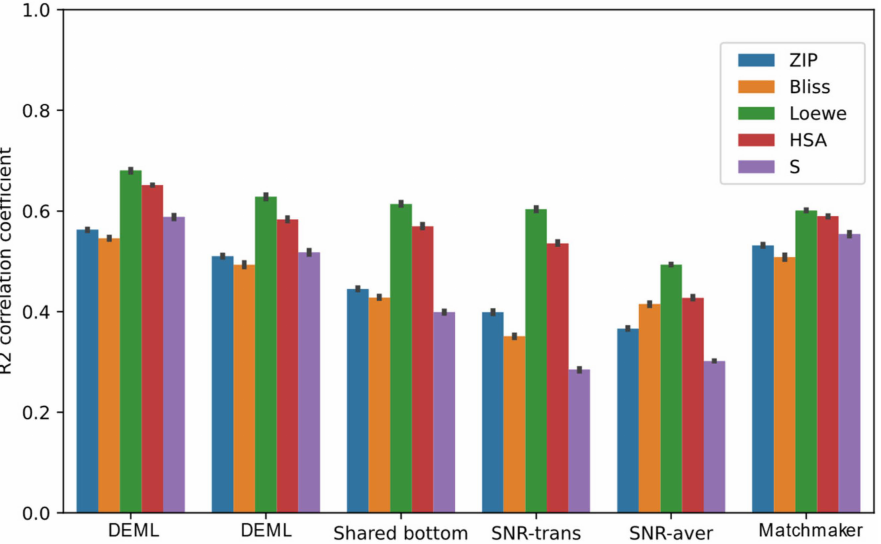
Figure 5. Prediction performance of DEML and multi-task comparison algorithms in all synergy regression prediction tasks. MatchMaker single-task refers to the best prediction performance with MatchMaker trained on each task separately. The error bar represents 95% confidence interval of five-fold